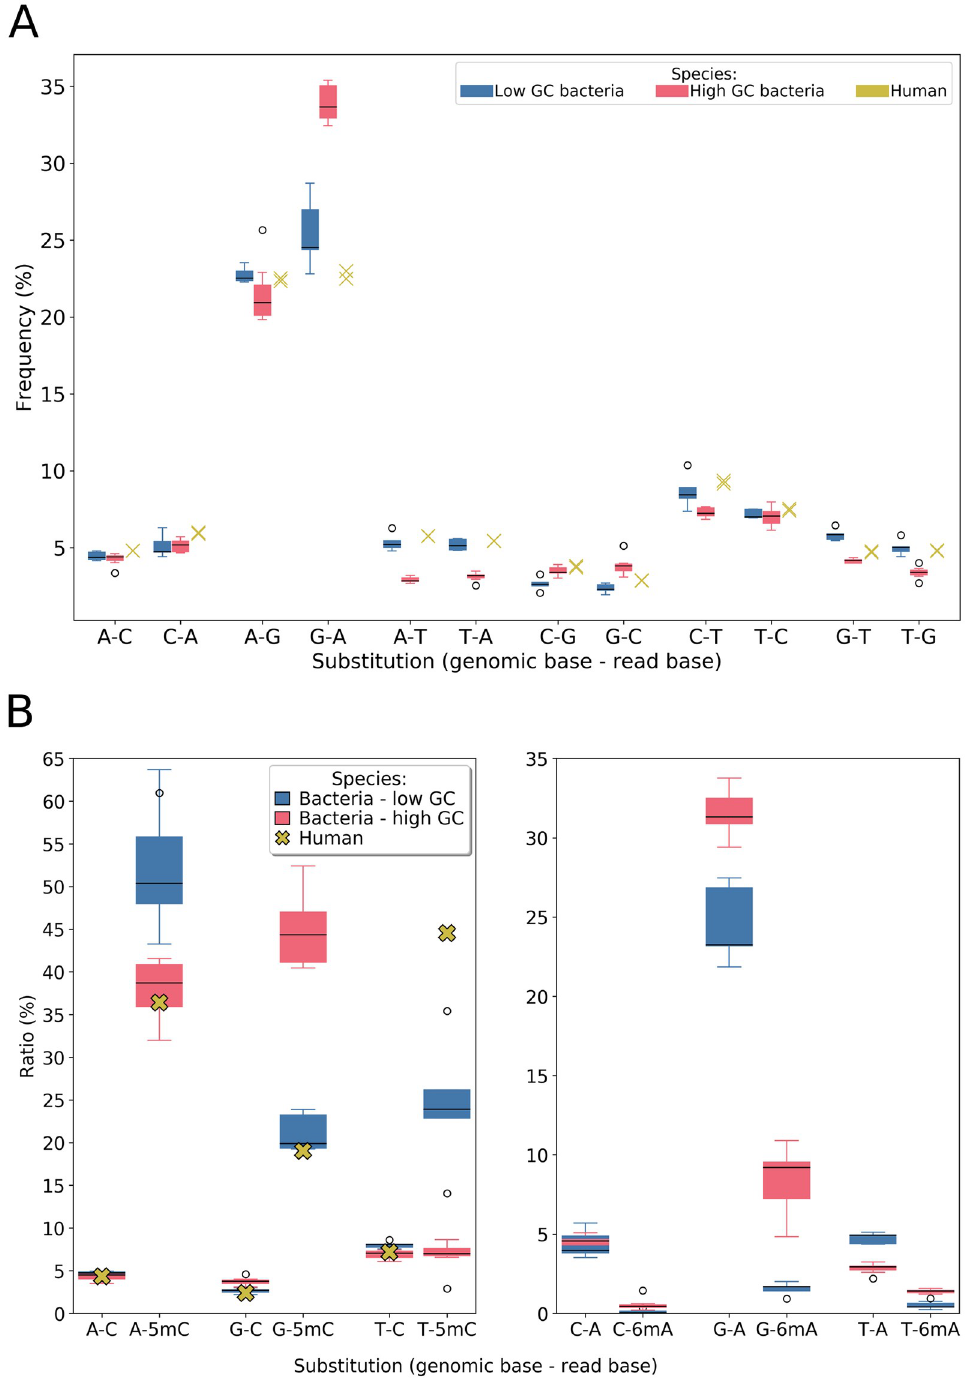
Fig 2. Substitution error profile for bacterial and human datasets. Results for bacterial datasets are presented with boxplots, those for human are displayed with crosses. A : Results obtained in HAC basecaller mode (unaware of methylation). B : Results obtained in methylation basecaller mode. We focused here on substitution to A and C in reads, the only methylations supported by Guppy (only the C-methylation for human data). For each substitution type, its abundance is given relatively to all substitutions, separating methylated and non-methylated